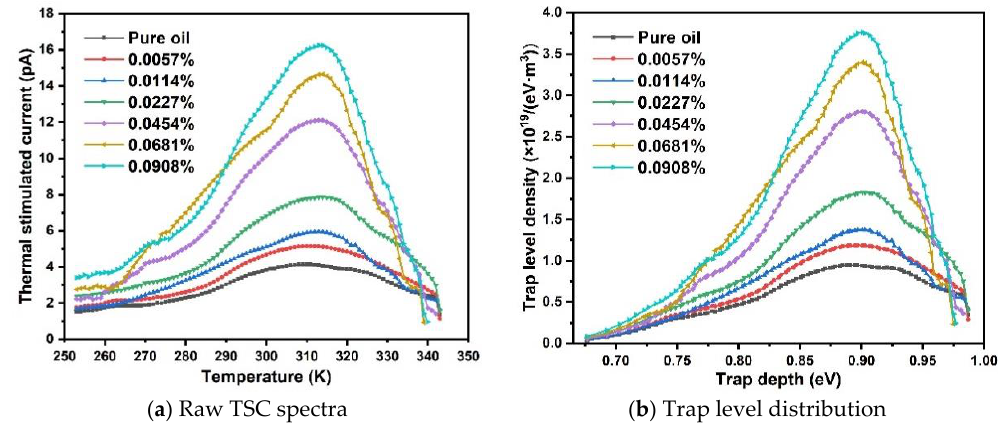
Figure 8. Thermal stimulated current (TSC) spectra and calculated trap level distribution of TiO 2 nanofluid.